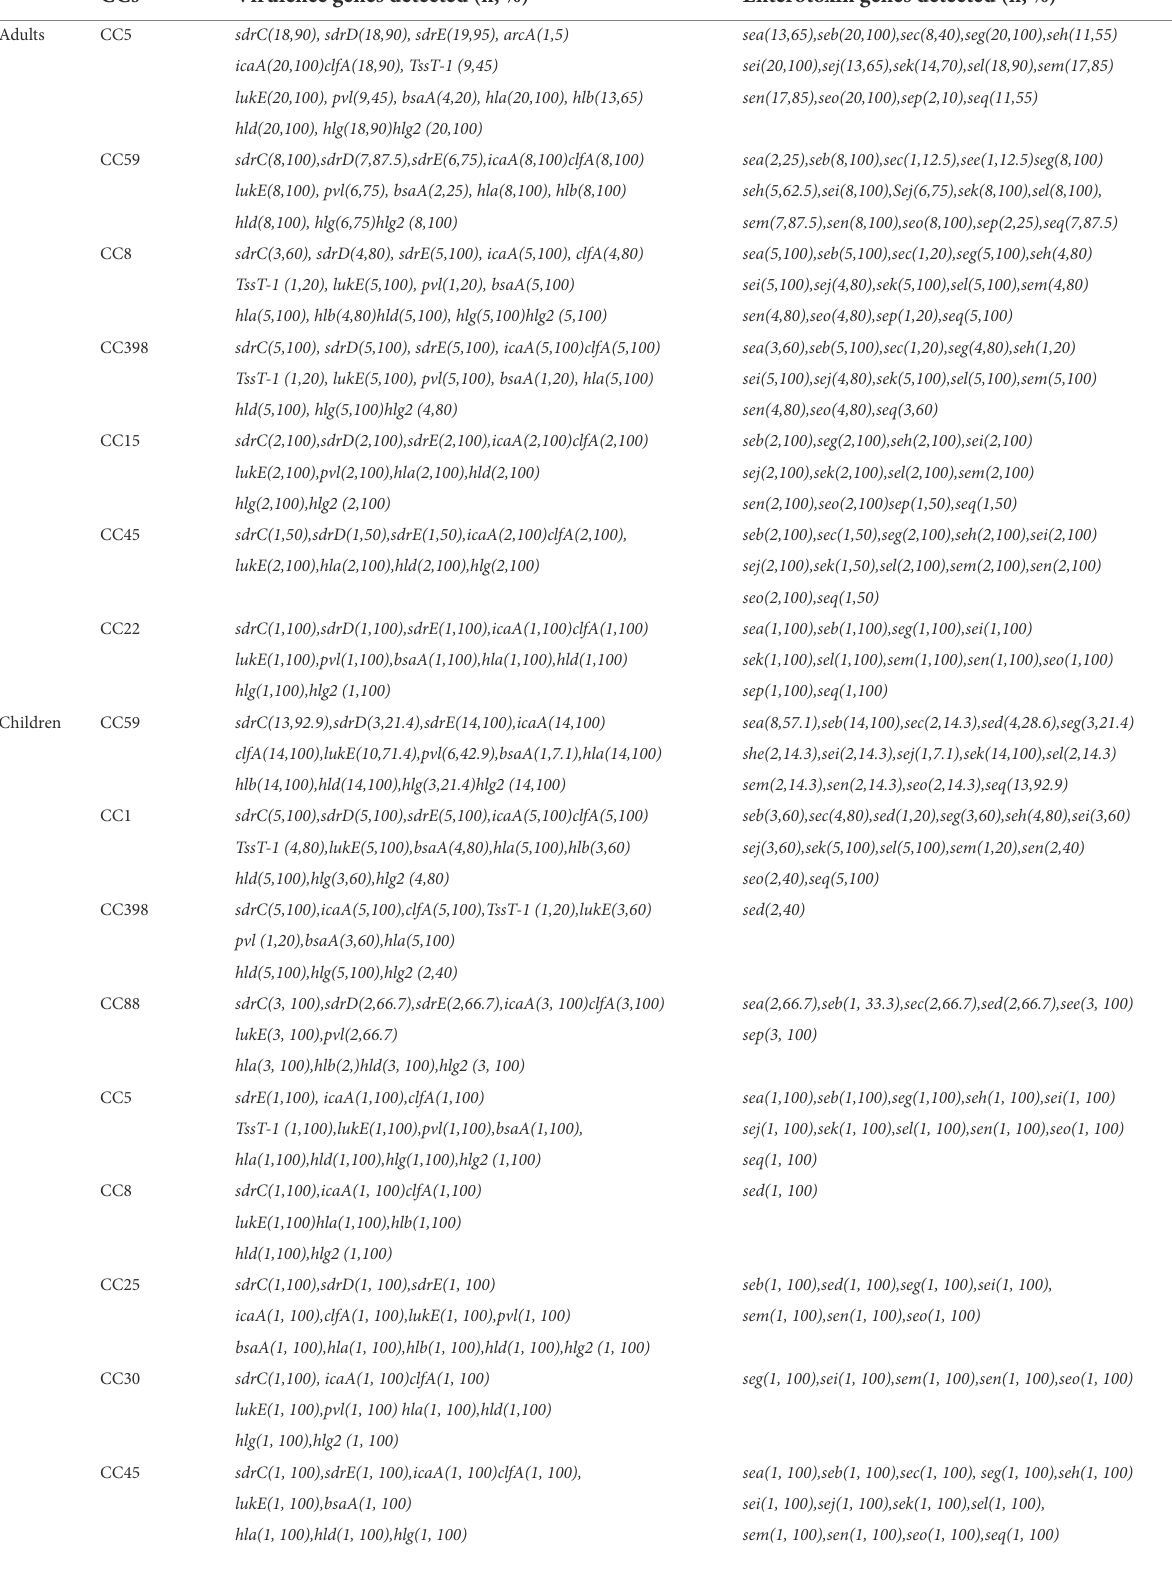
TABLE 2 Frequencies of virulence and enterotoxin genes among the molecular types of 77 bloodstream infection methicillin-resistant S. aureus (MRSA) obtained from